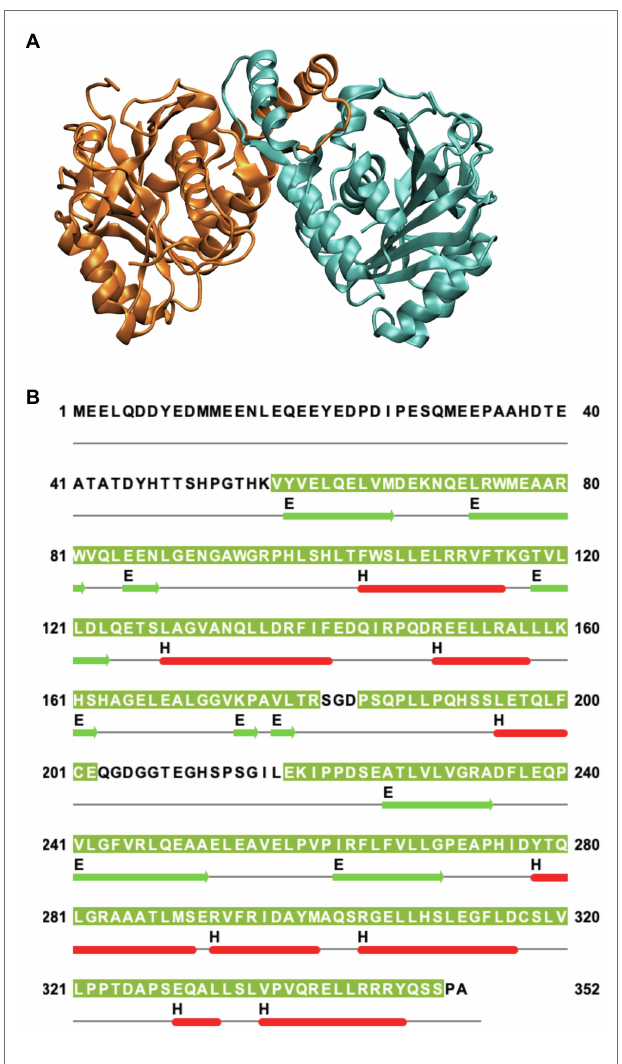
FIGURE 1 | (A) Side view of the structure of the dimeric cytoplasmic domain of human Band 3 (PDB: 4KY9). The two subunits are shown in orange and cyan. (B) Corresponding sequence of human Band 3 cytoplasmic domain. The regions for which structural data exist for the Band 3 cytoplasmic (based on chain A of the 4KY9 structure in the Protein Data Bank) are indicated by olive green background. Helical (H) and β -sheet (E) regions are shown in red and green, respectively. Cysteine residues are located at C201 and C317. N-terminal disordered region (Residues 1–54) is not present in this structure. This figure was created using